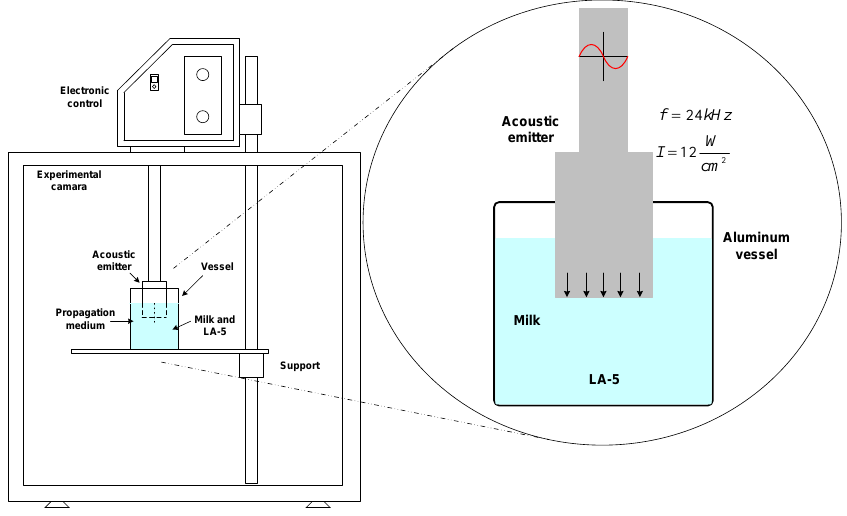
Figure 1. Configuration of the ultrasound application .